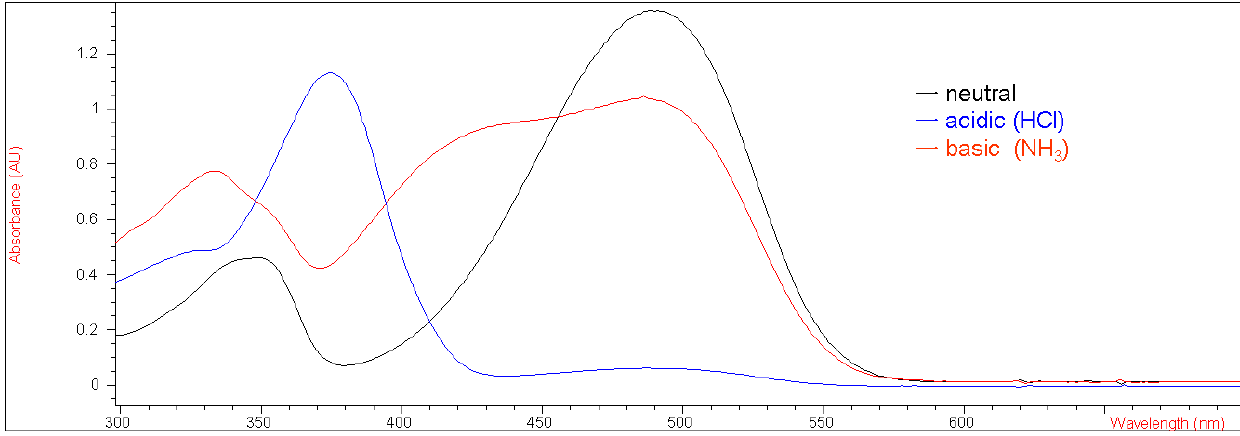
Figure 1. UV-vis spectra of 5a (2.74 x 10 -5 M in CH